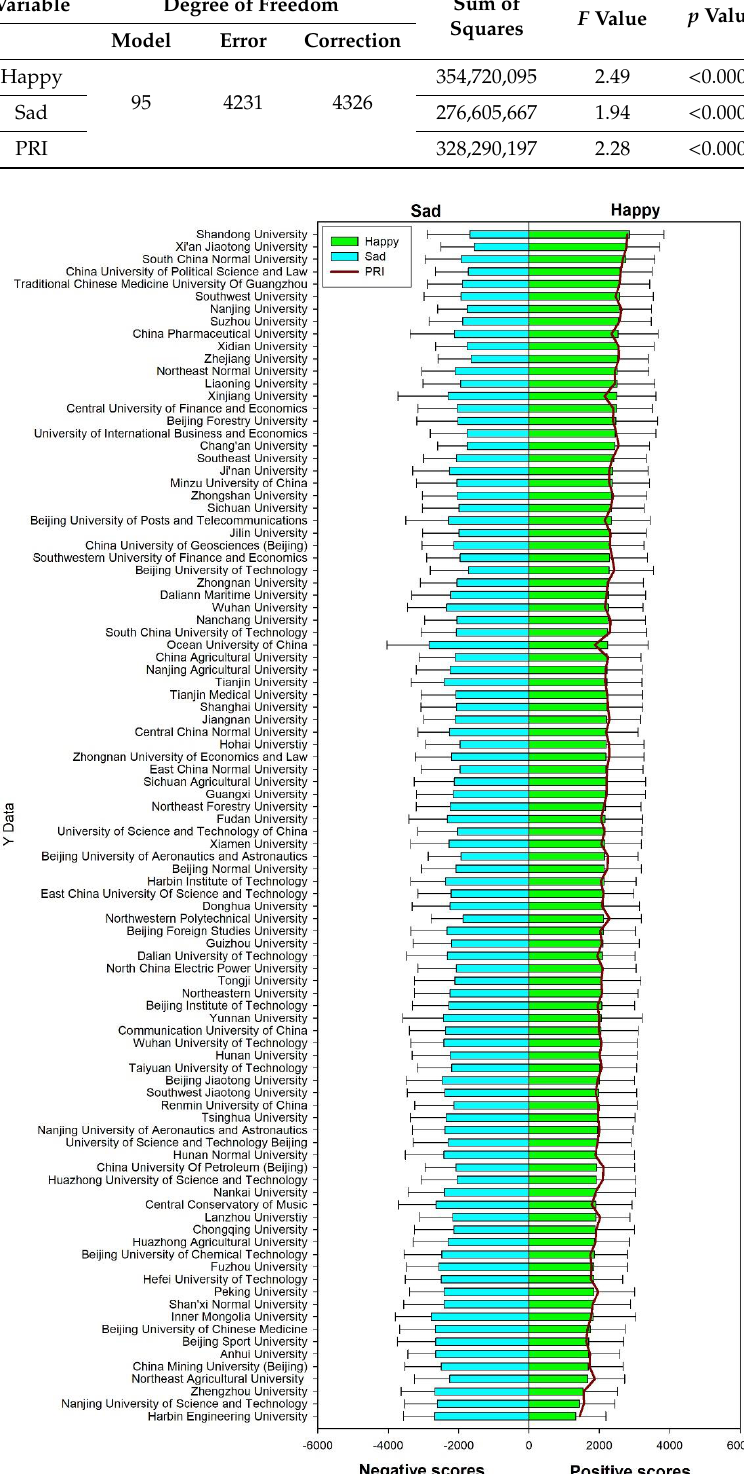
Figure 1. Ranked scores of happy and sad expressions and the positive response index (PRI) among selected 211-Project university campuses across mainland China. Universities are ordered by the growing score of happy expression. Different letters marked for significant difference are shown in Tables S2–S4.